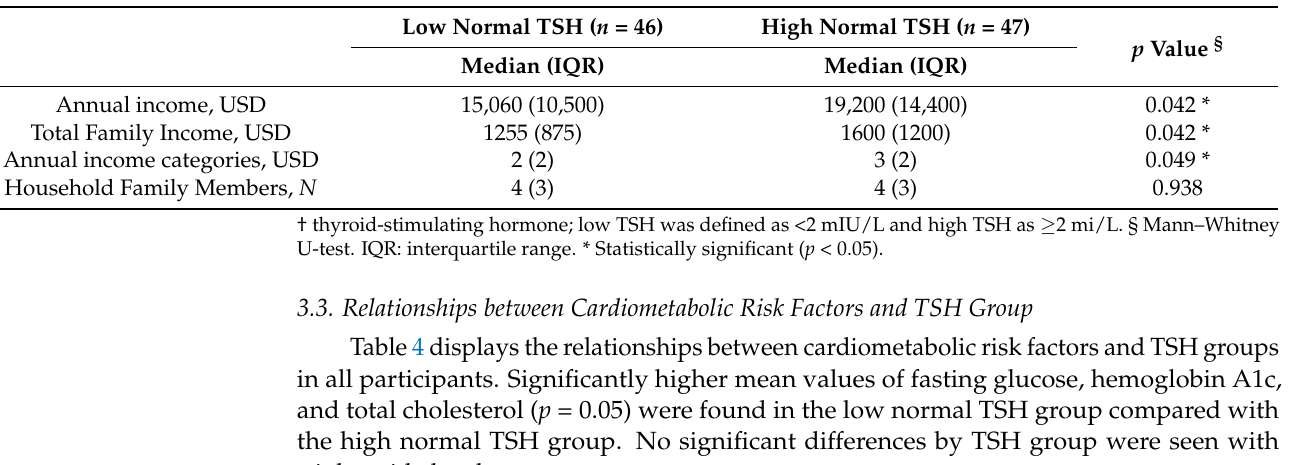
Table 3. Comparison of Economic Variables by TSH Group †.